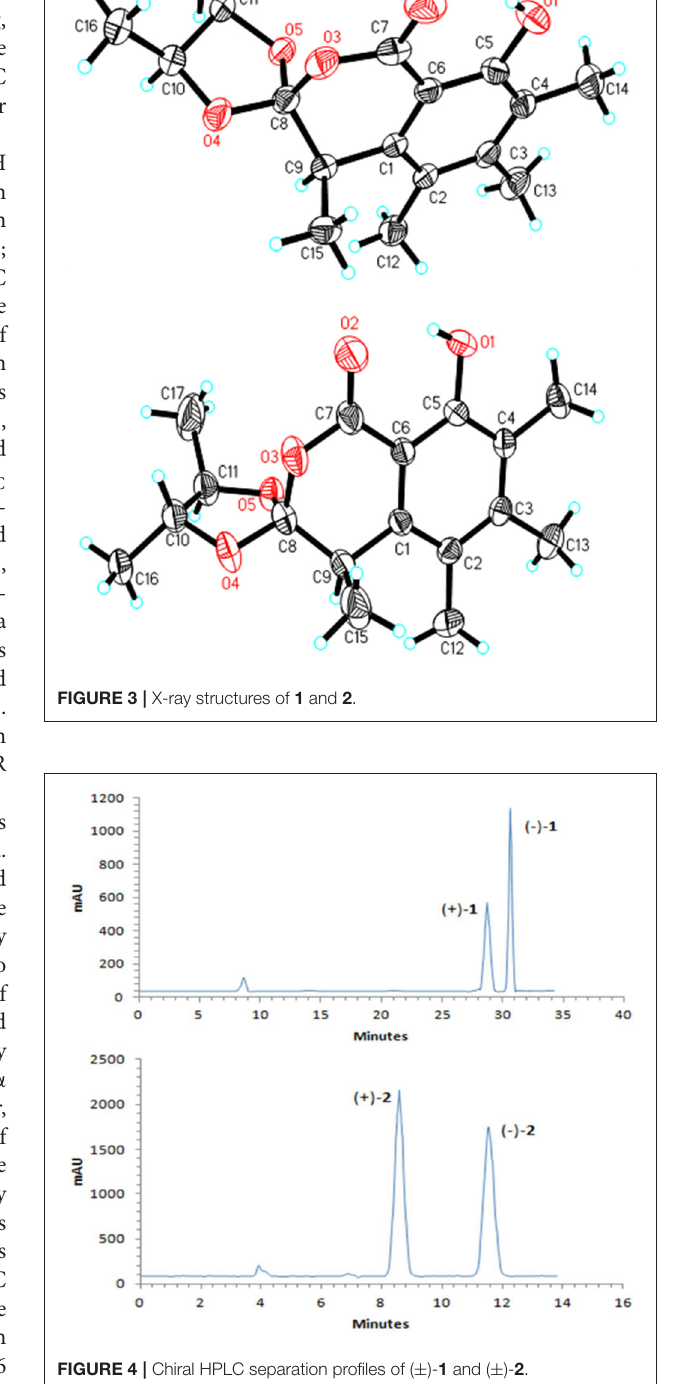
functional theory (TDDFT) calculations at the B3LYP/6-31G(d) level. As shown in Figure 5 , the calculated ECD curve of 9 R ,10 S ,11 S - 1 displayed good agreement with the